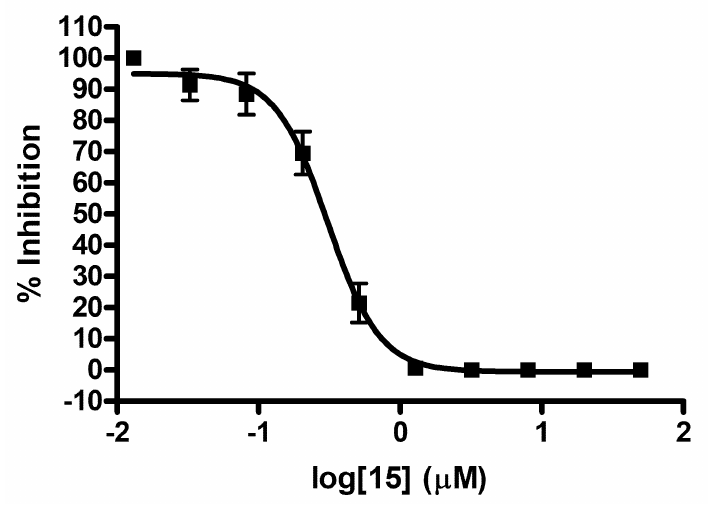
Figure 3. Dose-response curve of the best compound, 15 . Values are represented as mean of four independent experiments, with standard error bars shown. Data were analyzed as nonlinear regression, sigmoidal dose-response (variable slope) curve fit in GraphPad Prism.